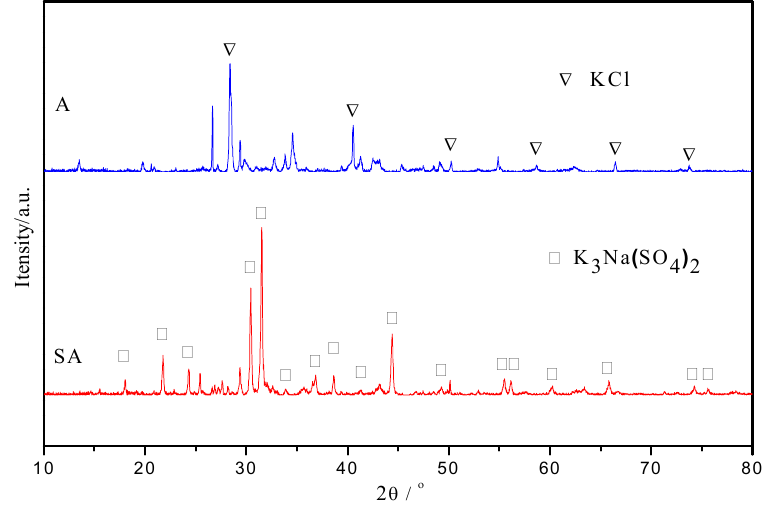
Figure 1. XRD patterns of the two ashes. A: Ash from raw eucalyptus. SA: Ash from 0.5 wt% H 2 SO 4 -impregnated eucalyptus.